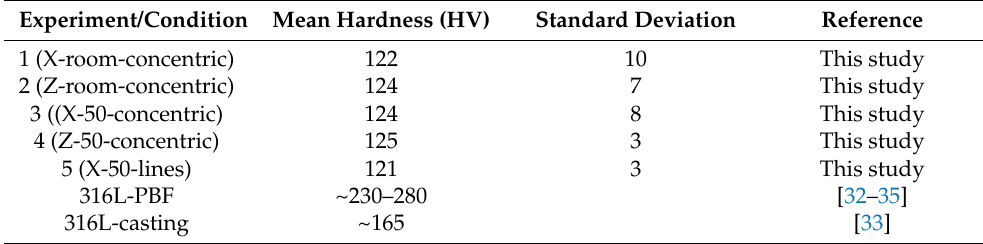
Table 3. Mean and standard deviation values of the hardness for experiments